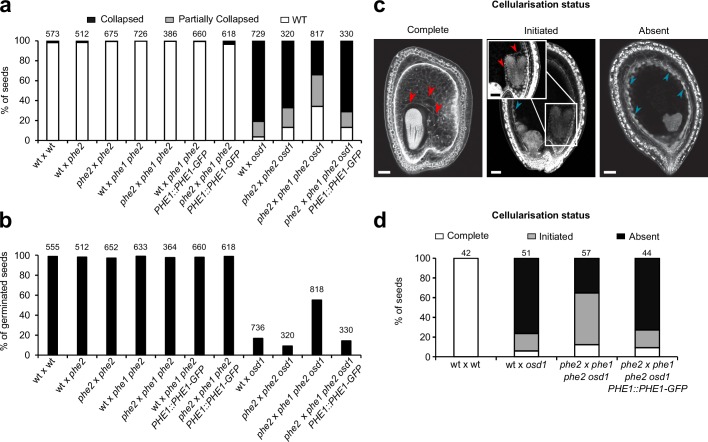
Rescue of 3x seed inviability in phe1 phe2.(a, b) Seed inviability phenotype of wild-type (wt) and paternal excess crosses in wt, phe1 phe2, and phe1 complementation lines (a), with respective seed germination rates (b). (c, d) Status of endosperm cellularization in wt and paternal excess seeds. (a, b, d) n = numbers on top of bars (seeds).